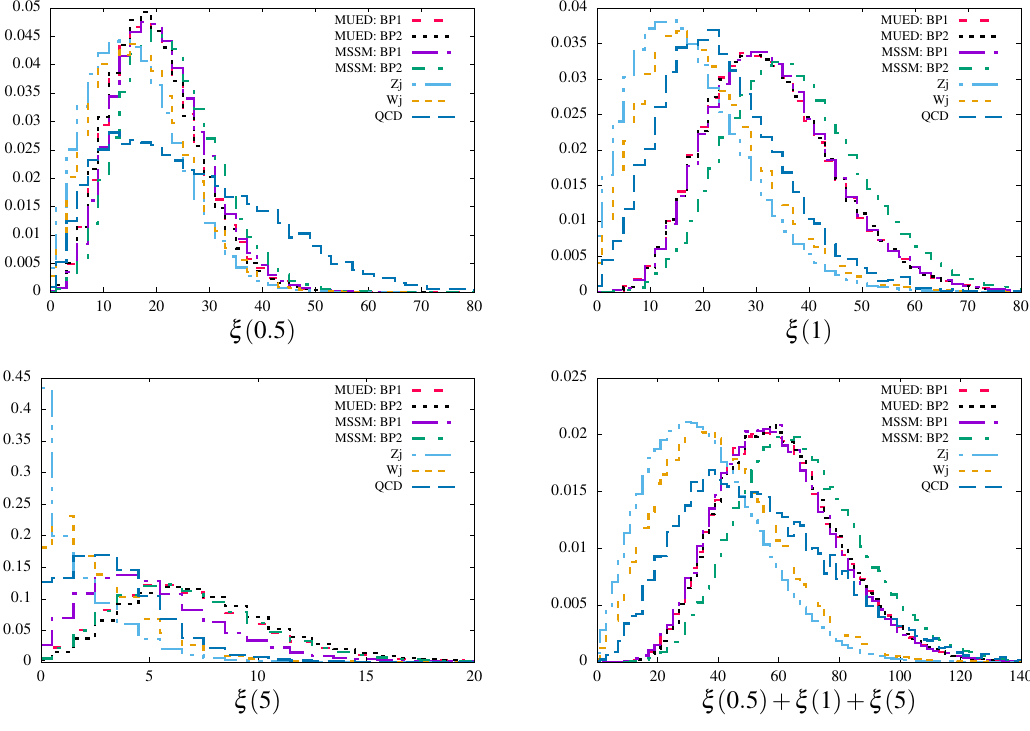
Figure 3 . Distribution of number of soft tracks are displayed. The tracks are p described in the text. Plots are shown for all four signal benchmark points as well as for the SM backgrounds. The (cid:12)gures are normalized to